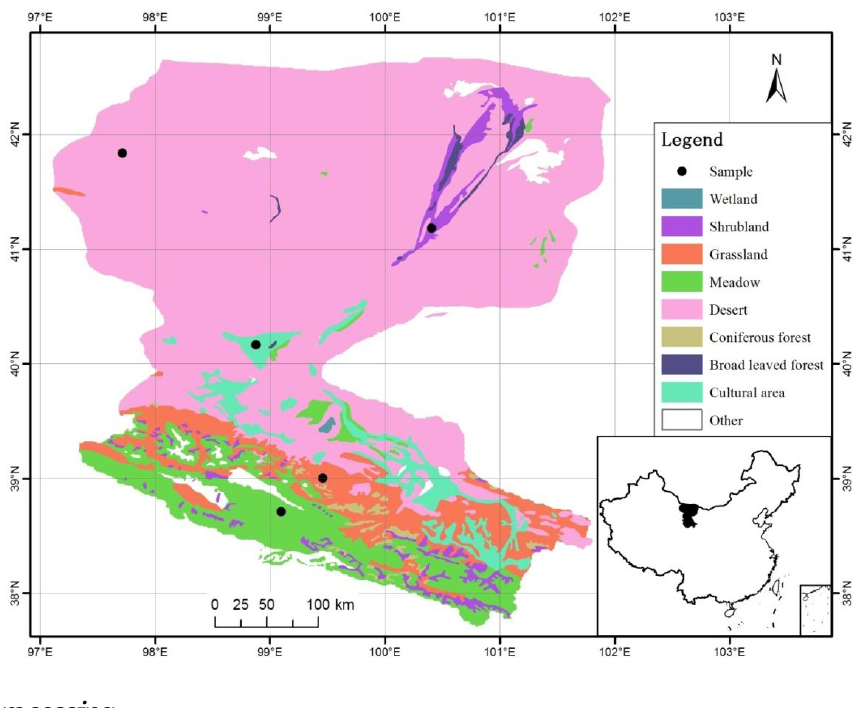
Figure 1. The vegetation types and the distribution of the sample points used for the comparison of the reconstruction techniques in the Heihe River